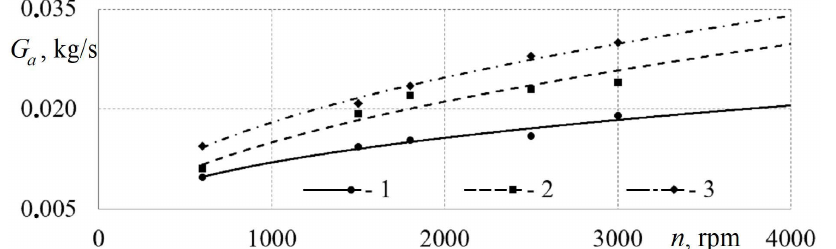
Figure 10. Dependences of the mass air flow G a on the crankshaft speed n through the intake system with channels of different diameters: 1— d = 26 mm; 2— d = 32 mm; 3— d = 40 mm.